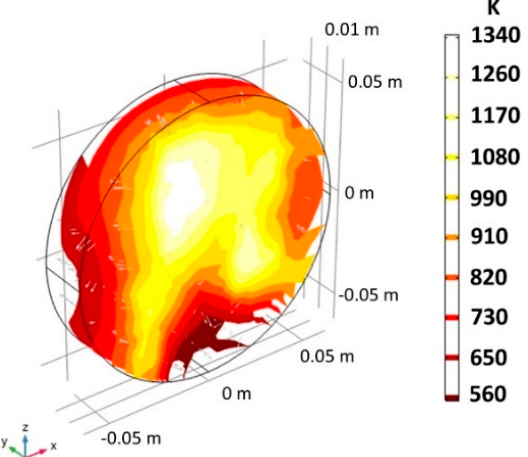
Figure 8. Isothermal surfaces corresponding to the 20 PPI absorber obtained from numerical simulations.